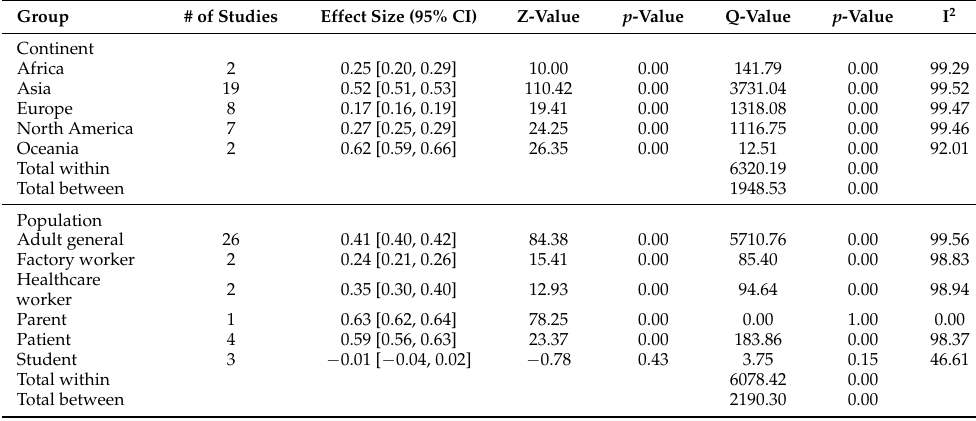
Table 4. The Meta-analysis Results of Subgroup Analyses (Subjective